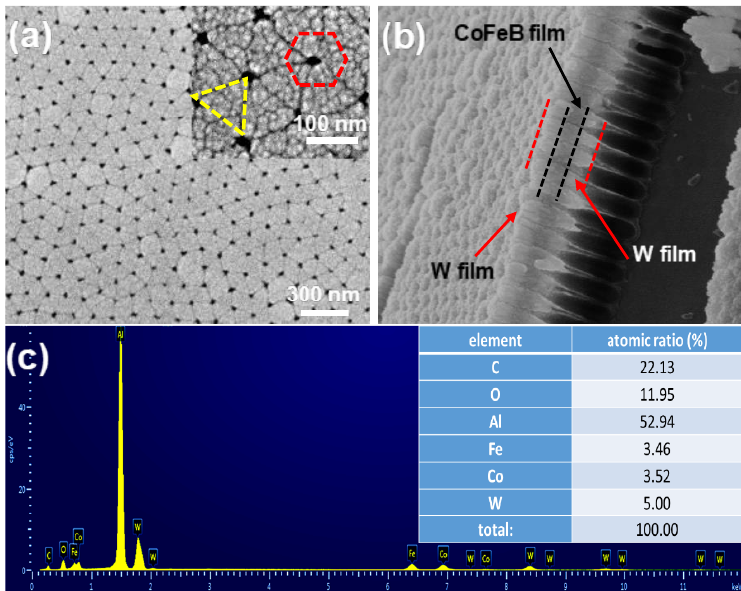
Figure 7. ( a ) Surface SEM image, ( b ) cross section SEM image, and ( c ) surface EDS spectrum of one of W/CoFeB (120 nm)/W multilayer thin films with a W thickness of 129 nm on the AAO substrate of 90 nm pore diameter and inter-spacing of 110 nm.